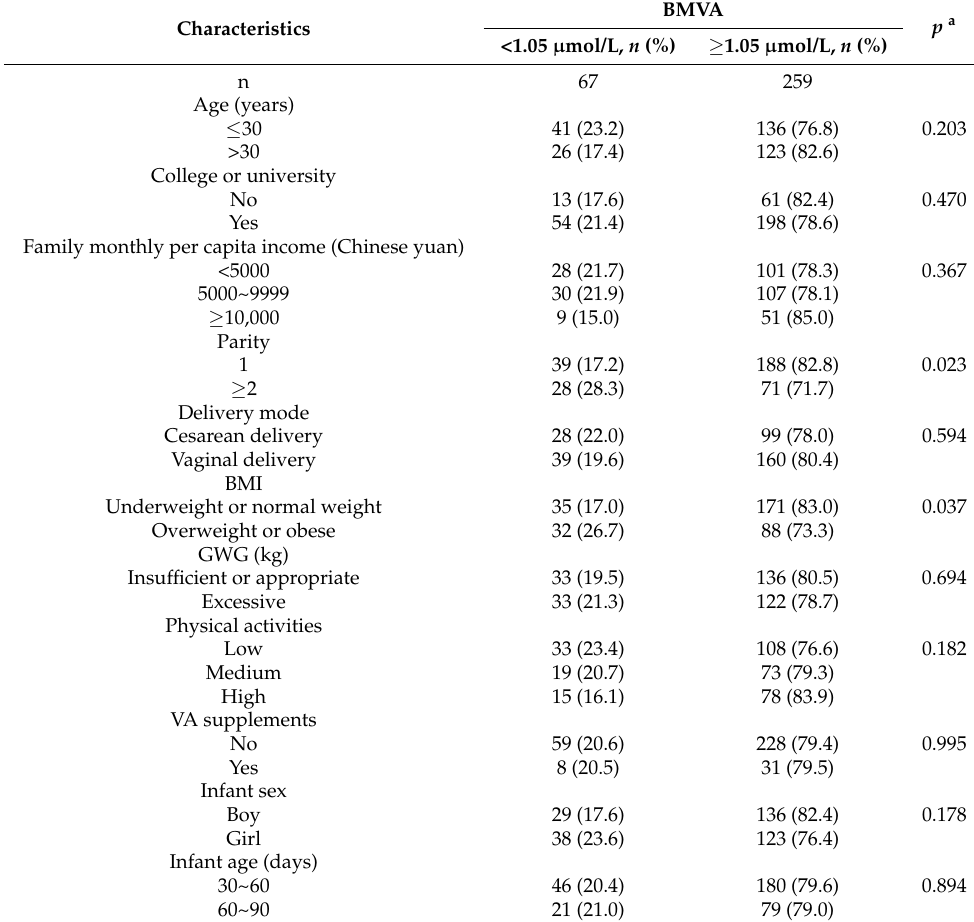
Table 2. Stratification of lactating women according to the recommended concentration of BMVA.